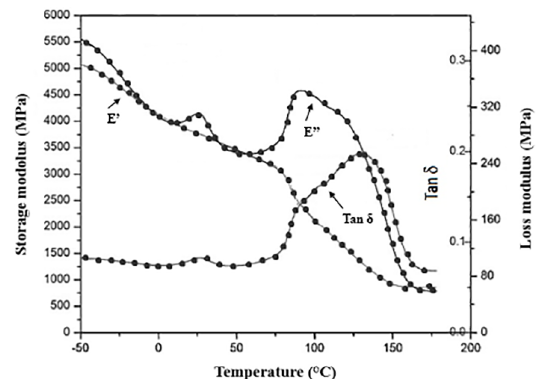
Figure 3. Variation of the dynamic-mechanical parameters with the temperature for the composite with 50 vol% of fique